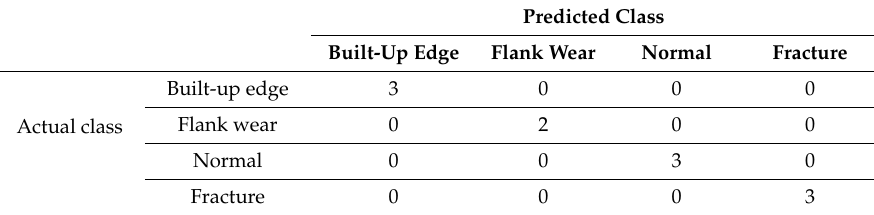
Table 4. Confusion matrix of the backpropagation neural network (BPNN) model (machining condition 9).